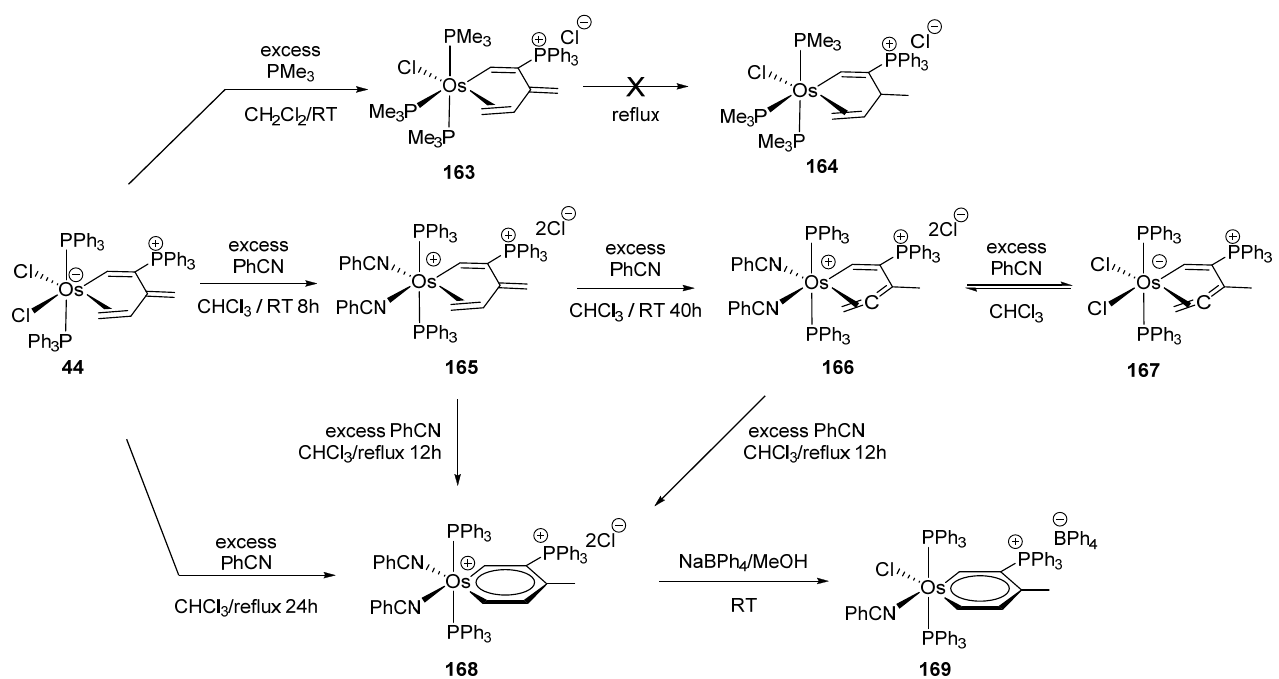
Figure 35. Studies of reactivity of complex 44 .